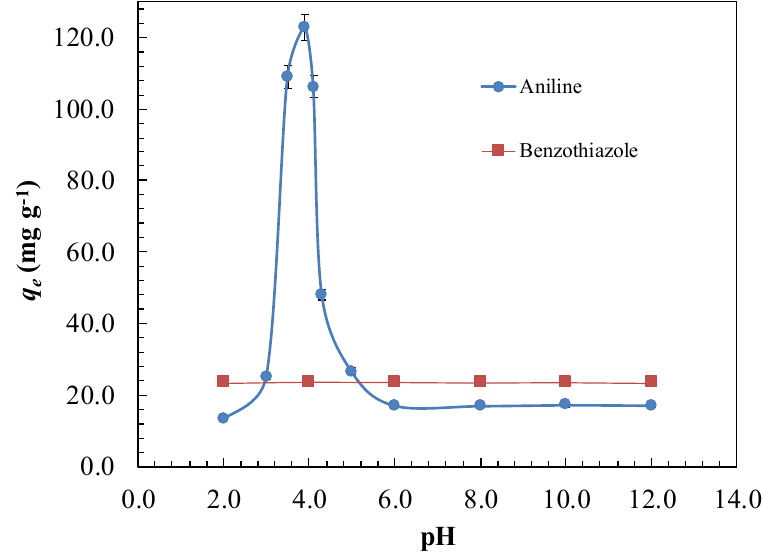
Figure 3. Effect of solution pH on aniline or benzothiazole adsorption on TiO 2 at equilibrium. Experimental conditions: C 0 = 22.0 mg L −1 , [TiO 2 ] = 100.0 mg L −1 , T = 25.0 °C.3.3. Adsorption Isotherms